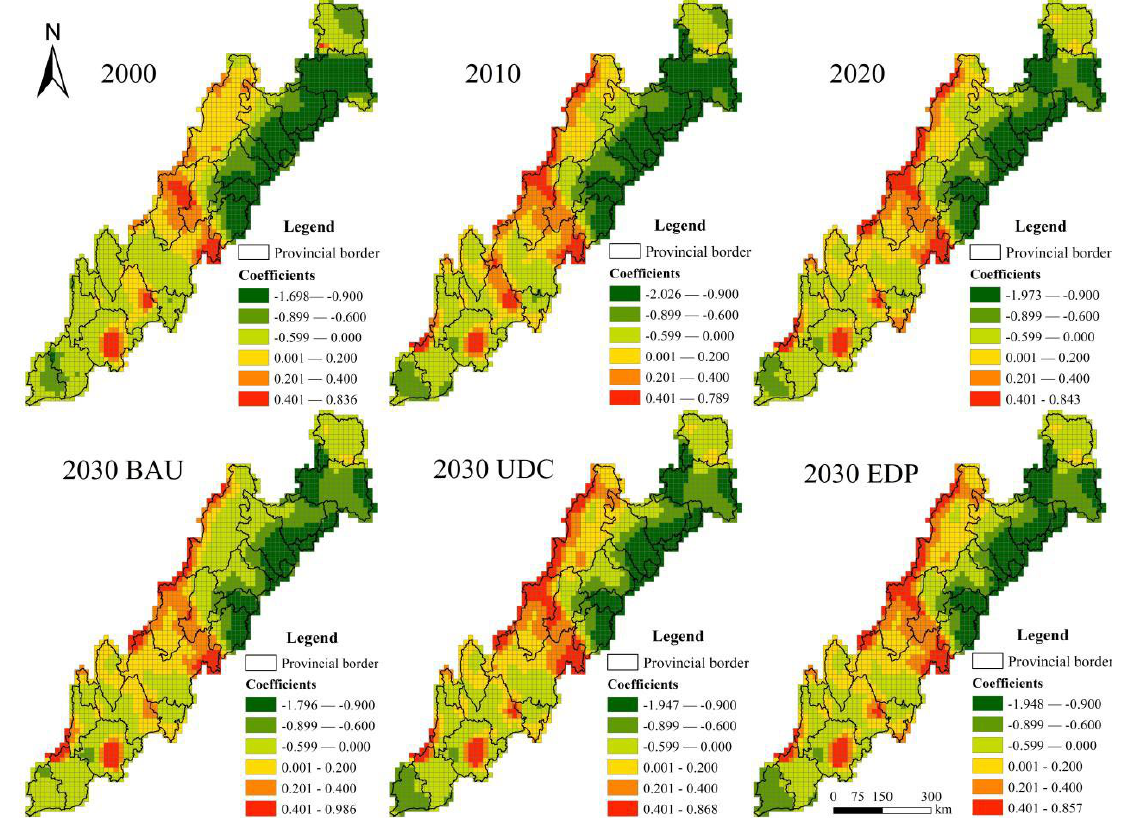
Figure 8. Spatial pattern of the MGWR regression coefficients for landscape ecological risk and ter- rain gradient changes. gradient